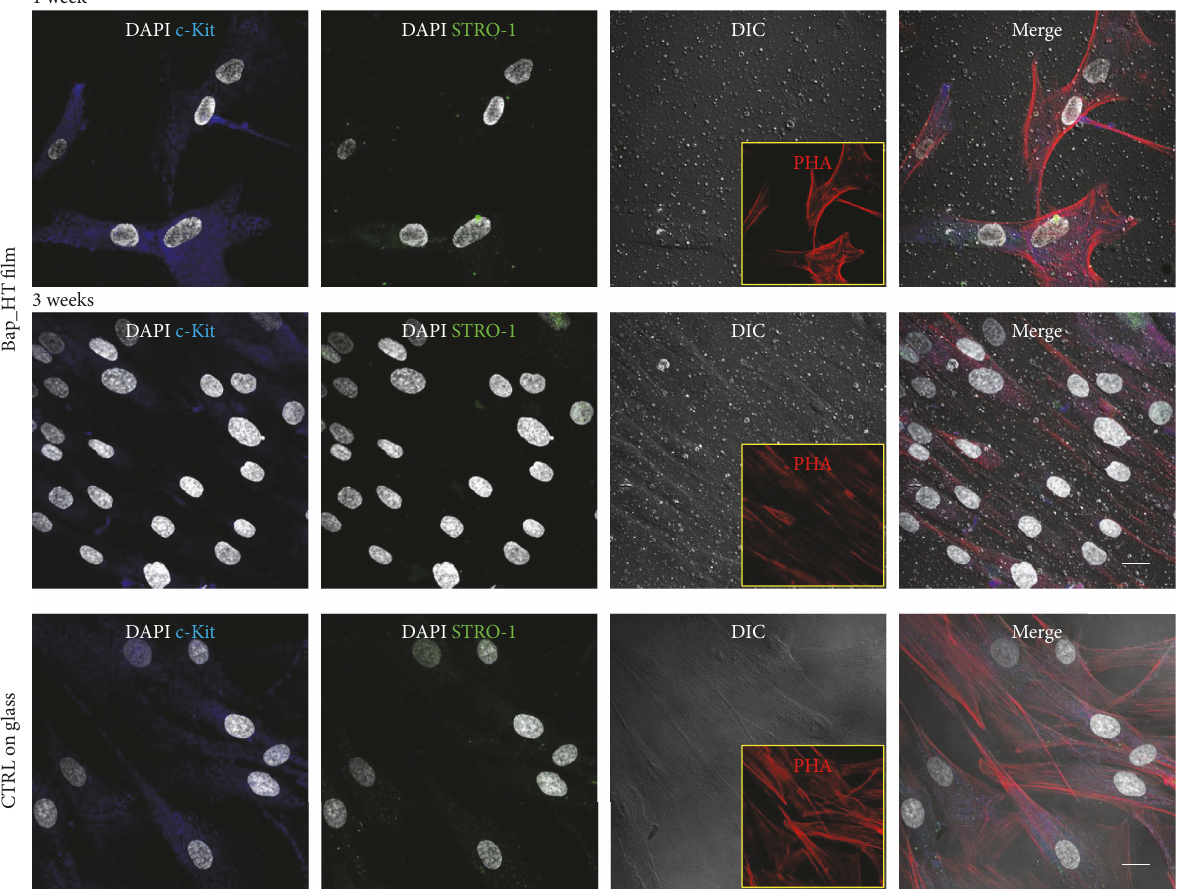
Figure 4: Evaluation of stemness marker expression by hDPSCs grown on BAp_HT fi lms at 1 and 3 weeks of culture. DIC images show the adhesion of the fi lms to the underlying surface and the presence of hDPSCs. Inserts reporting phalloidin labeled cells represent cell morphology of hDPSCs cultured on BAp_HT fi lms after 1 and 3 weeks of culture. Nuclei were counterstained with DAPI. Scale bar: 10 μ